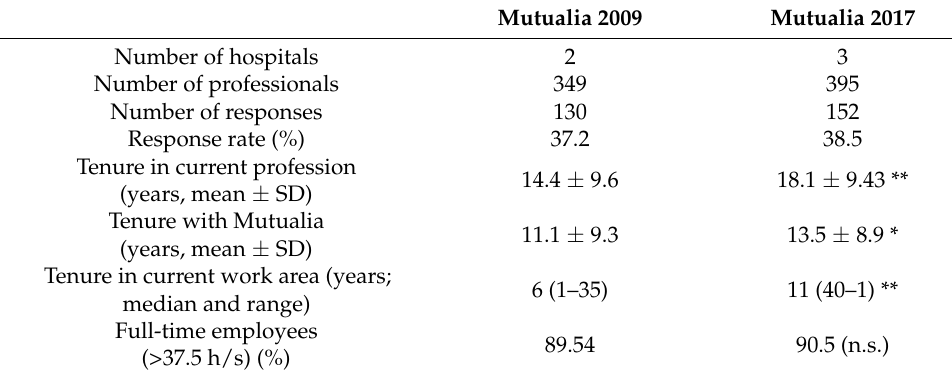
Table 1. Infrastructure, personnel, and response rate to the survey at Mutualia (2009 and 2017).